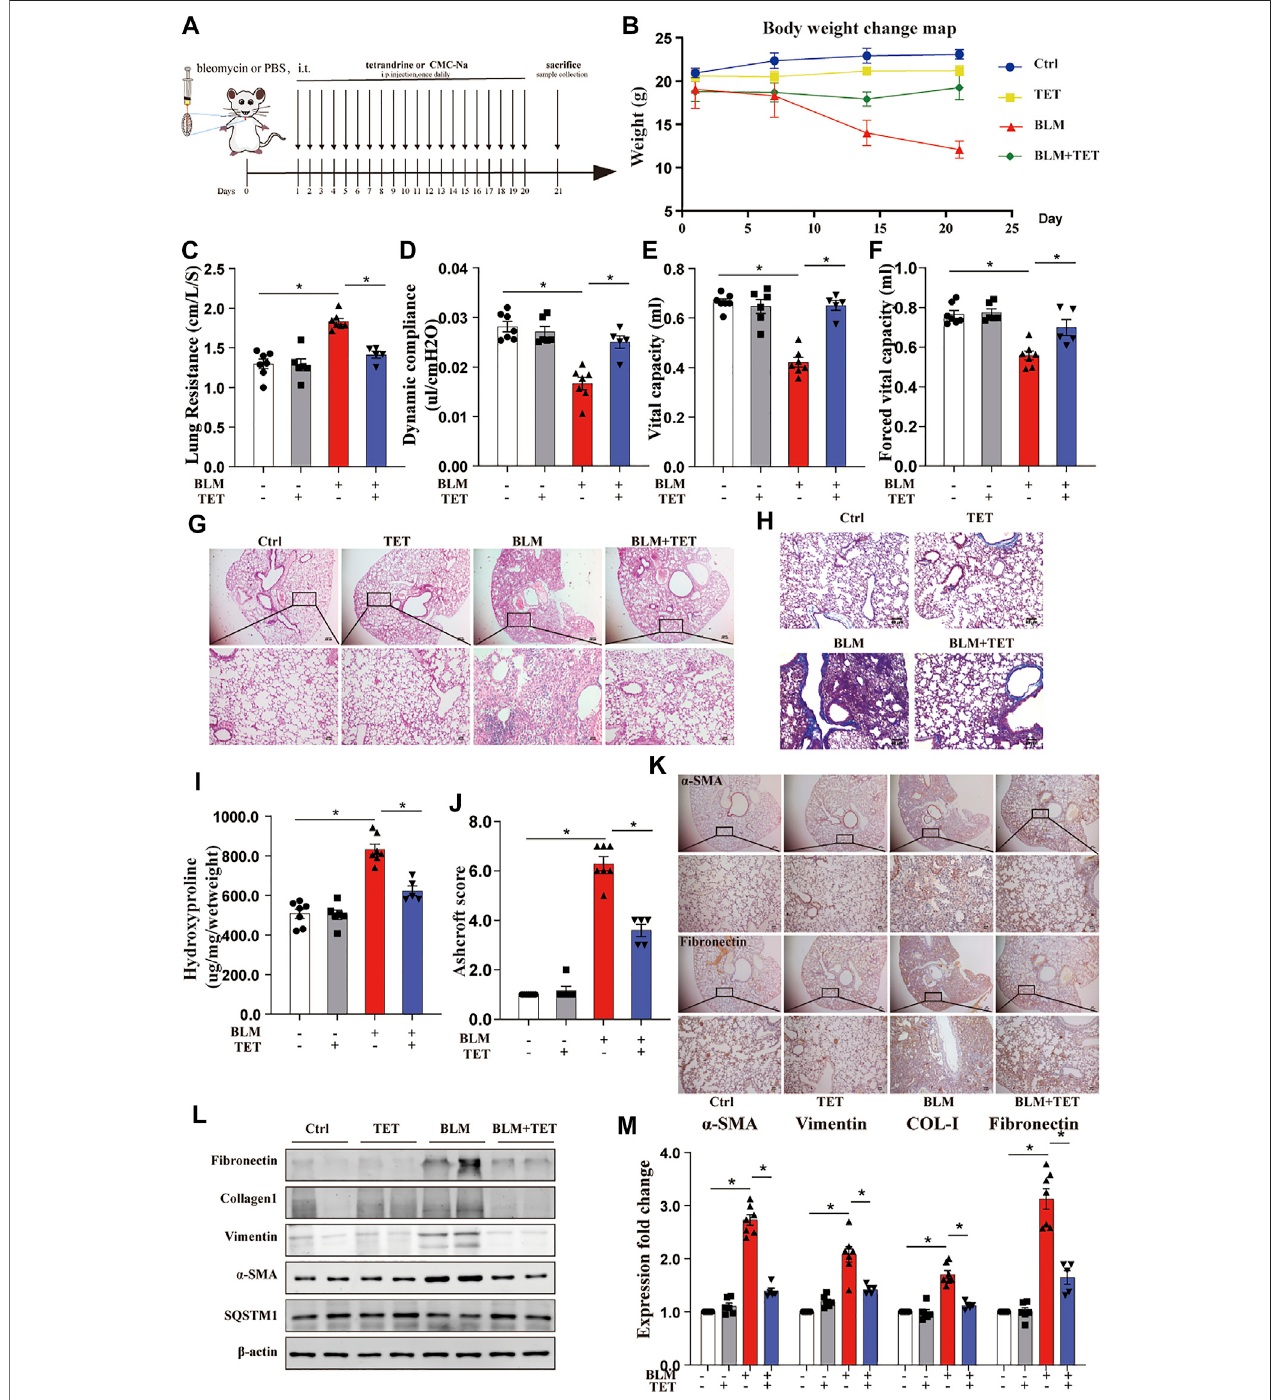
FIGURE9| TETtreatmentprotectsagainstpulmonary fi brosisinducedbybleomycin.Mice,weretreatedprophylacticallywitheithervehicle(sodiumcarboxymethyl cellulose, i. p, daily) or TET (20 mg kg − 1 · d − 1 , i.p.) starting on Day 1 after receiving a single intratracheal administration of BLM. The control group received intratracheal PBS. (A) Schematic diagram of the time course of TET treatment in a mouse model of BLM-induced pulmonary fi brosis. (B) Changes in body weight were presented relative to the initial weight. (C-F) The pulmonary function parameters were measured by pulmonary function test. (G) Lung tissue was sectioned at day 21 and performed HE staining. Scale bar of top images: 100 μ m, below images: 40 μ m. (H) Lung tissues were stain with Masson trichrome staining. Scale bars: 40 μ m. (I) Ashcroft scores were analyzed. (J) Hydroxyproline (HYP) expression of each group by hydroxyproline assay. (K) The protein expression of α -SMA (left images) and fi bronectin (right images) in lung sample were examined by immunohistochemical staining. Scale bar of top images: 100 μ m. Scale bar of below images: 40 μ m. (L-M) Lung tissues were treated as described in (A) and subjected to immunoblots of fi brosis and autophagy-associated proteins(L) and densitometric analysis was obtained (M) .Thedatawerepresentedasthemeans ± SEM(n ≥ 5).Two-wayANOVAfollowedbyDunnett ’ smultiplecomparisonstestwasusedforstatisticalanalysis.* p < 0.05.